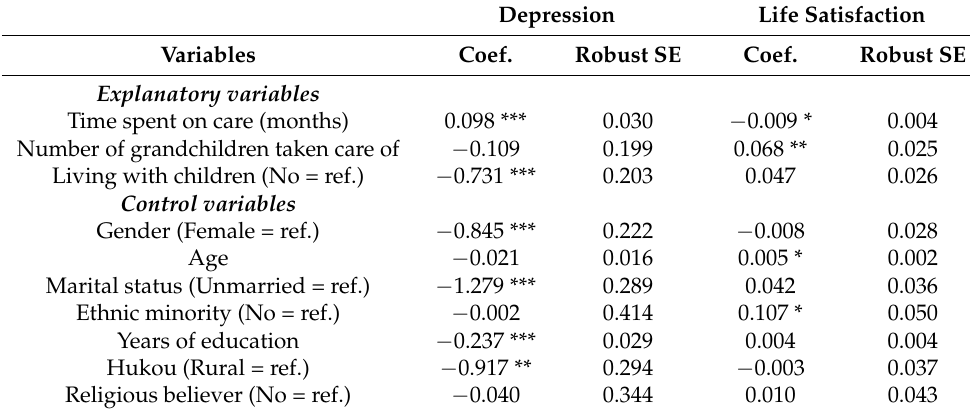
Table 3. Multilevel regression among Chinese adults who took care of grandchildren last year. Depression Life Satisfaction Variables Coef. Robust SE Coef. Robust SE Explanatory